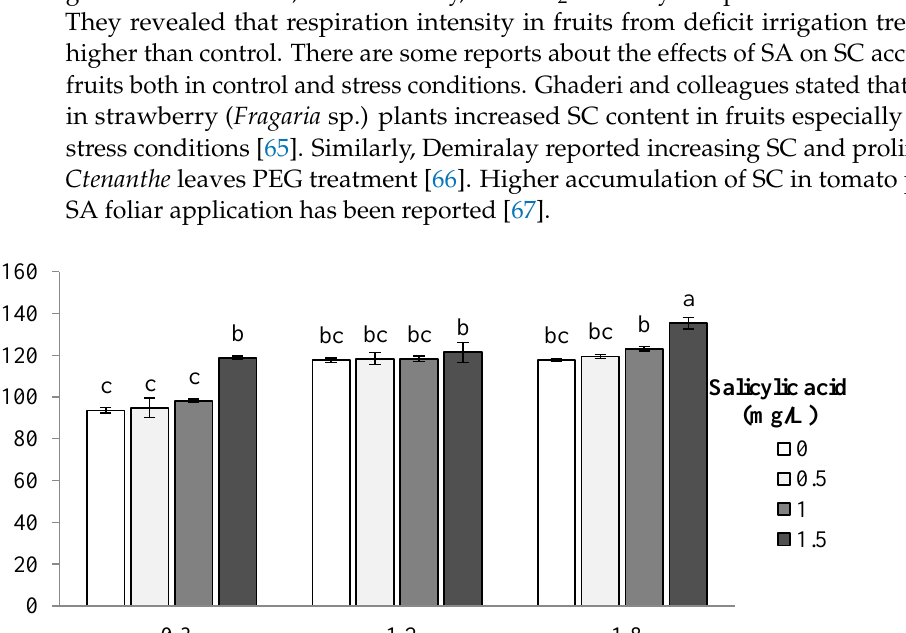
Table 5. Interaction of irrigation regime at three soil matric potential levels and salicylic acid on some fatty acid composition (The soil matric potential (MPa) value was measured just before irriga- tion).